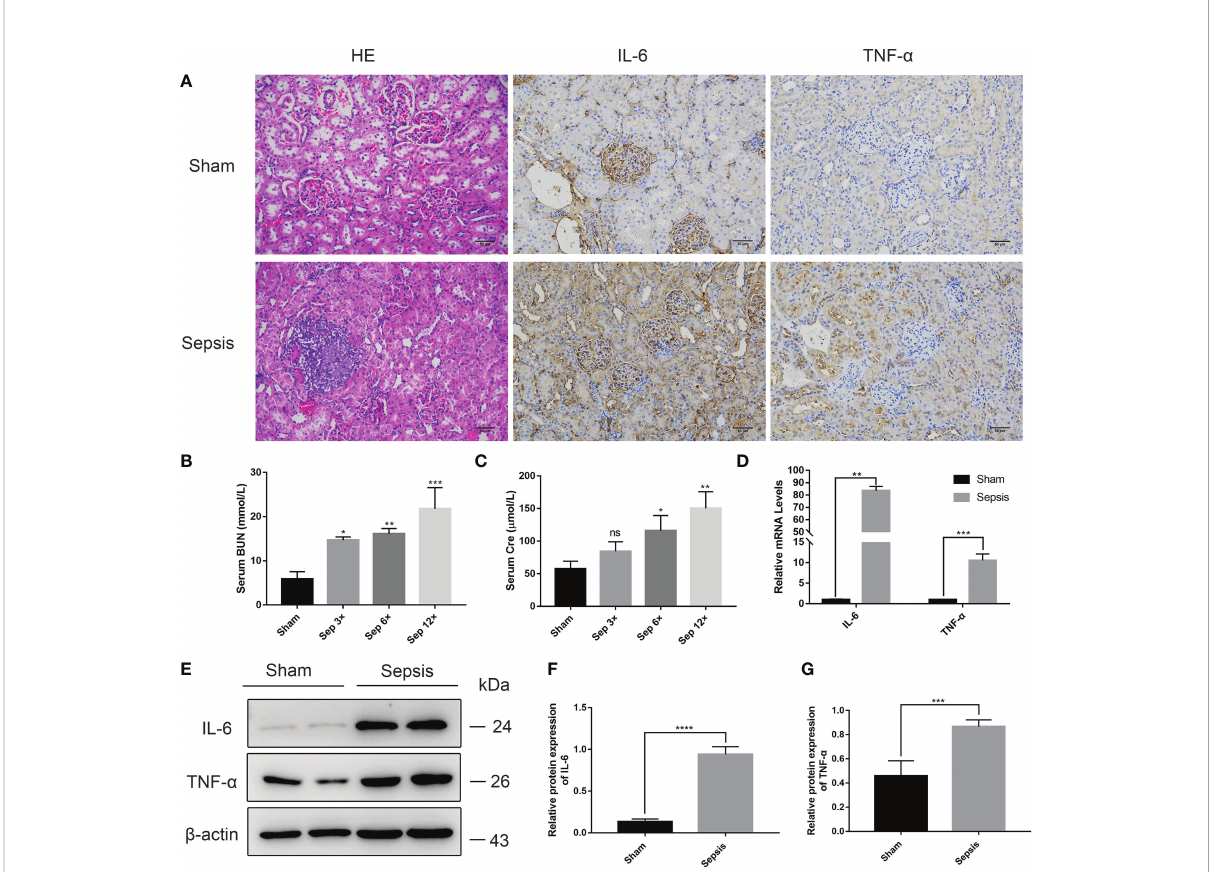
FIGURE 6 Kidney injury in the rat model of urinary sepsis (A) Representative images of hematoxylin and eosin (H&E) staining of kidney tissue from the sham and sepsis groups, immunohistochemical analysis of IL-6 and TNF- a in kidney tissue (magni fi cation, 200×; bar, 50 m m). (B, C) Serum BUN and Cre levels in rats 24 hours after E. coli or saline inoculation of the renal pelvis. (D) The relative mRNA levels of IL-6 and TNF- a in kidney tissue. (E) Expressions of IL-6 and TNF- a in kidney tissue were tested by western blot, and b -actin was used as a loading control. (F, G) Quantitative data of the levels of IL-6 and TNF- a . The sep 6× group was selected as a representative of the sepsis groups. Values were shown as mean±SD. *P < 0.05, **P < 0.01, ***P <0.001, and ****P < 0.0001 vs sham group. "ns" means "not